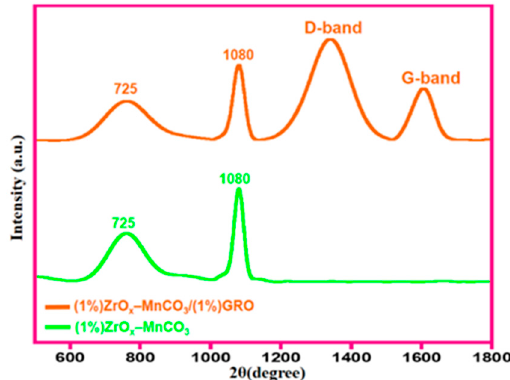
Figure 3. Raman spectra of un-supported (1%)ZrO x –MnCO 3 catalyst and (1%)ZrO x –MnCO 3 /(1%)GRO nanocomposite.